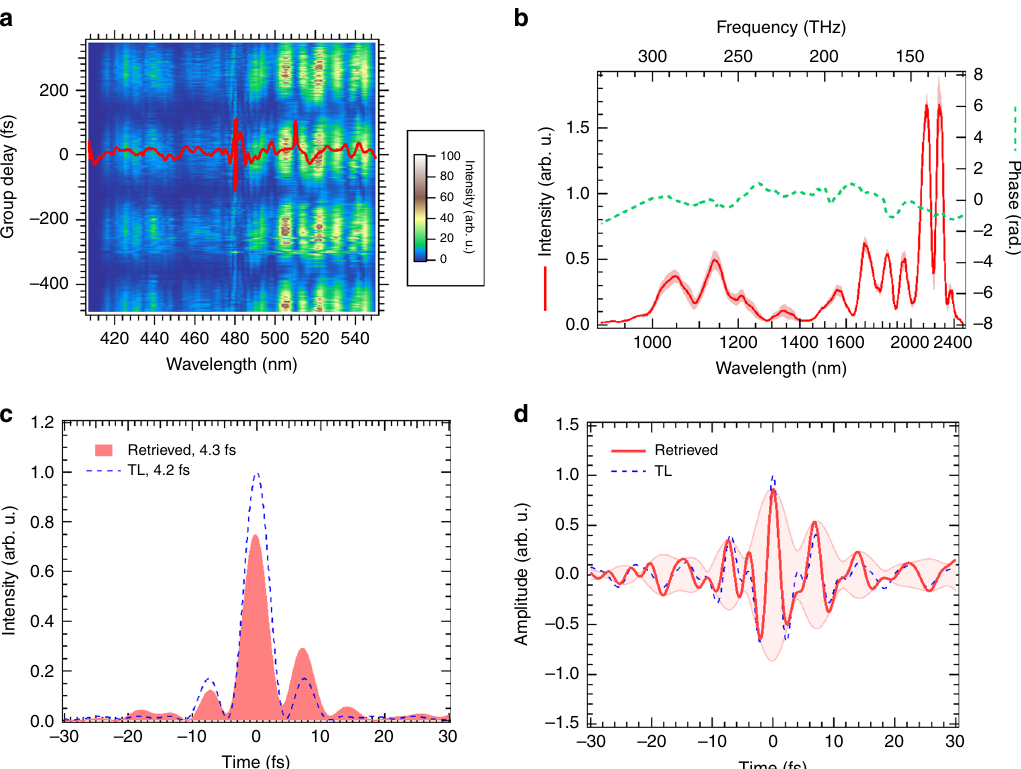
Fig. 6 Pulse characterization using two-dimensional shearing interferometer (2DSI). a 2DSI spectrogram. The group delay (GD) obtained from the spectrogram is depicted as a solid curve. b Measured spectrum (solid curve) of the output pulse from OPA3 and the spectral phase (dashed line) retrieved from the measured GD in a . The shaded area indicates the standard deviation for the measured spectra. c Temporal pro fi le (intensity) calculated from the measured spectrum and the retrieved phase is shown as a shaded area. The pulse duration is estimated to be 4.3 fs in FWHM, which is comparable to the pulse duration of the transform-limit (TL) pulse, depicted as a dashed curve, with a pulse duration of 4.2 fs. d Electric fi eld calculated from the measured spectrum and the retrieved phase is depicted as a solid curve. We assume the CEP to be zero in this calculation. The shaded area speci fi es the envelope of the electric fi eld. The electric fi eld of the TL pulse is also shown as a dashed curve for